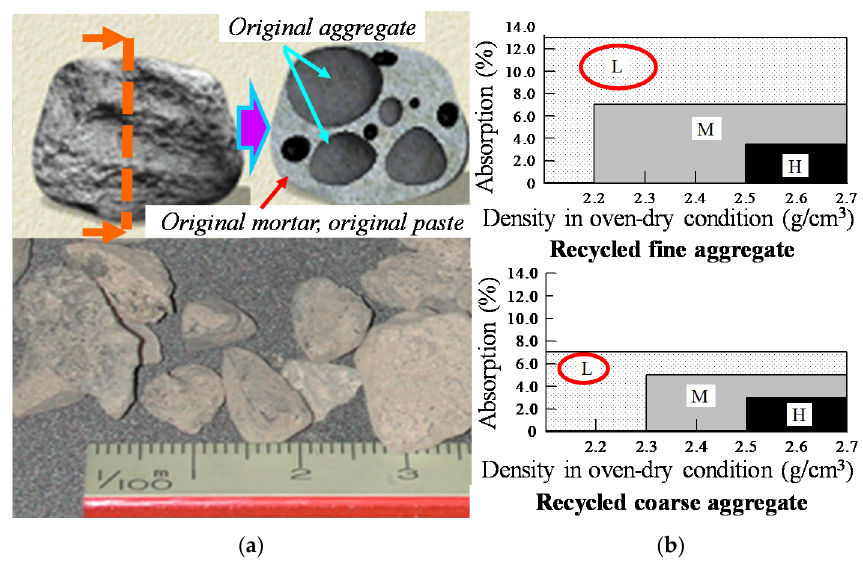
Figure 1. ( a ) Image of recycled aggregate class L and ( b ) quality standard [3,5].